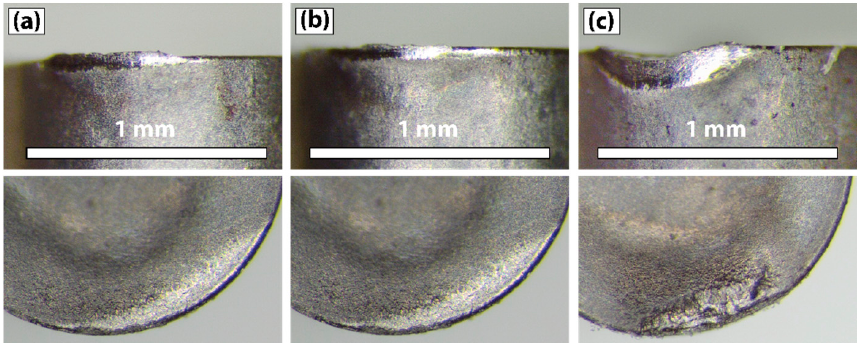
Figure 4. Flank and rake face wear of the uncoated tool after 120 m of machining length for config- uration 1: ( a ) corresponds to 40 m/min; ( b ) to 50 m/min; and ( c ) to 60 m/min.